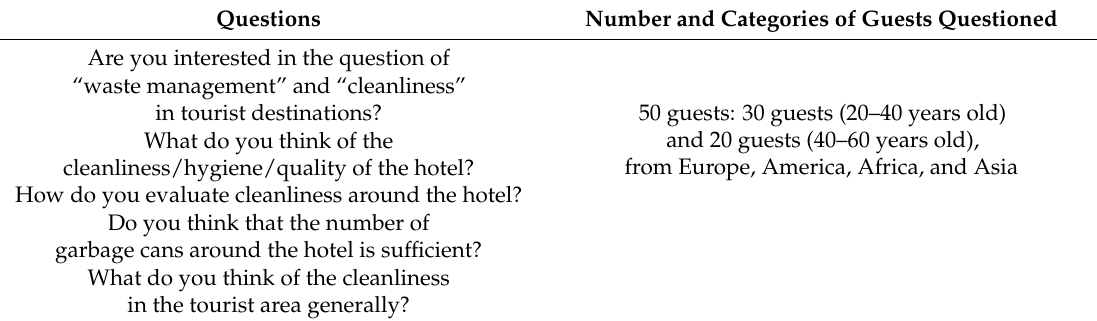
Table 6. Interview questions involving hotel guests.